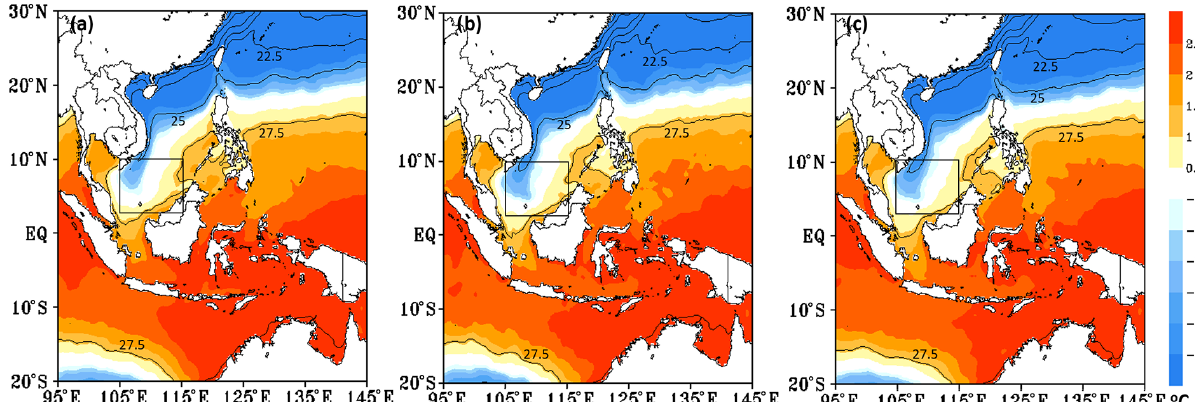
Figure 9. Same as Fig. 8 but for SST (solid line contour) and SST anomaly relative to the SCS-CT threshold of 26.4 ◦ C (shaded). The dark-blue solid rectangle represents the SCS-CT index area (following Koseki et al., 2012).